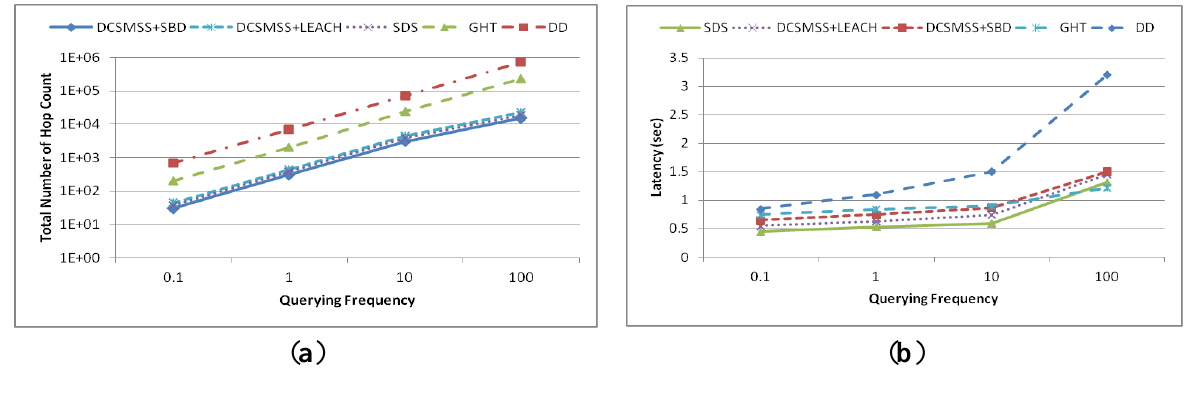
Figure 18. ( a ) Total number of events and ( b ) discovery